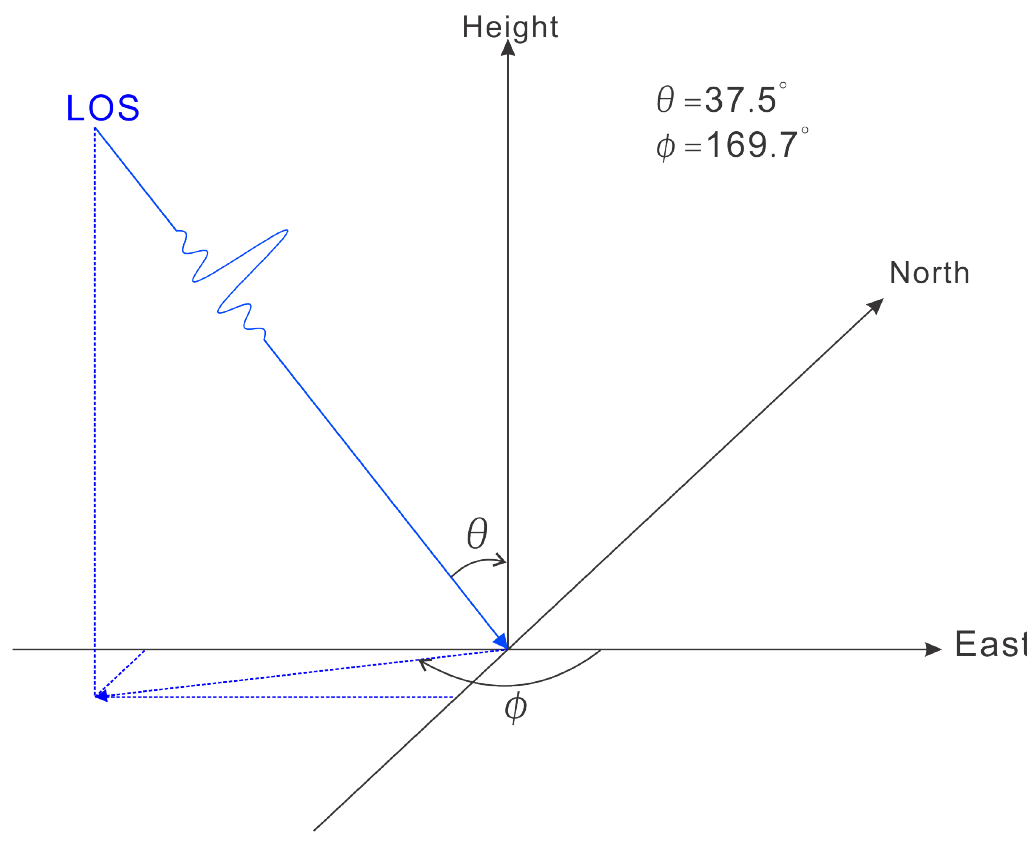
Figure 5. SAR side-looking geometry and angular